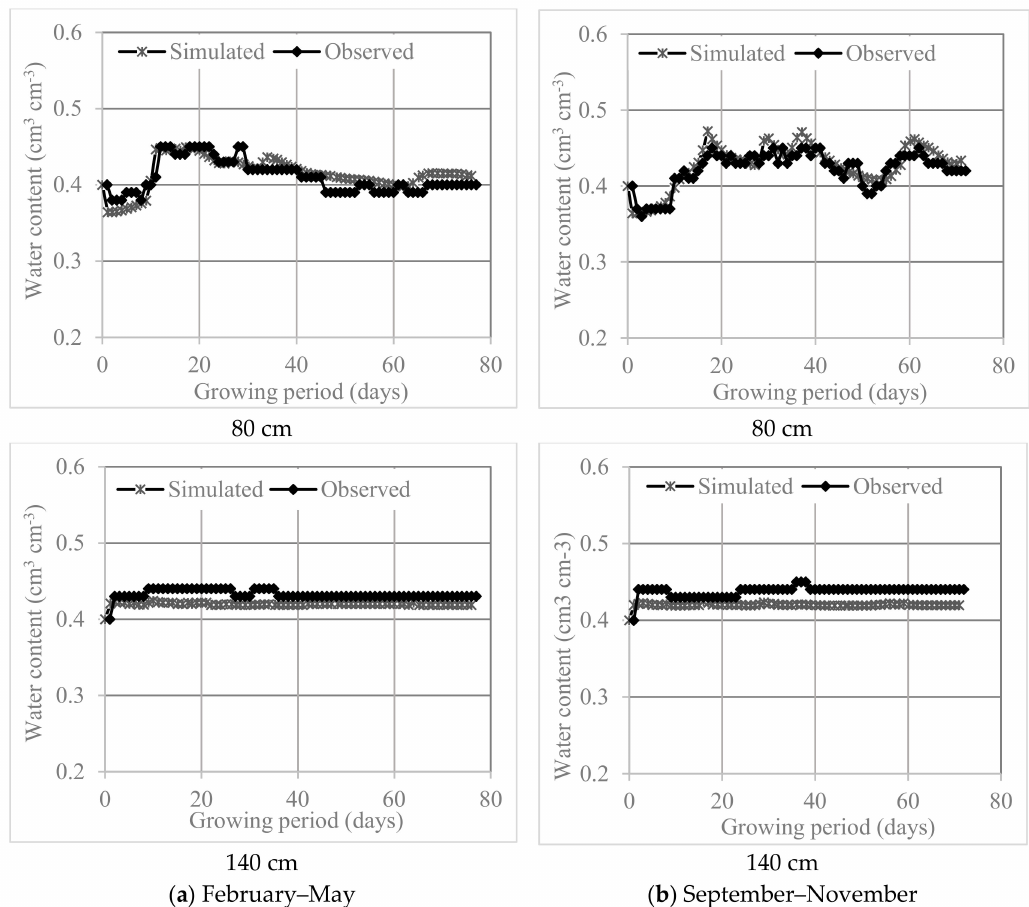
Figure 7. Simulated and observed soil water contents below the root zone (60–140 cm) during the ( a ) first season and ( b ) second